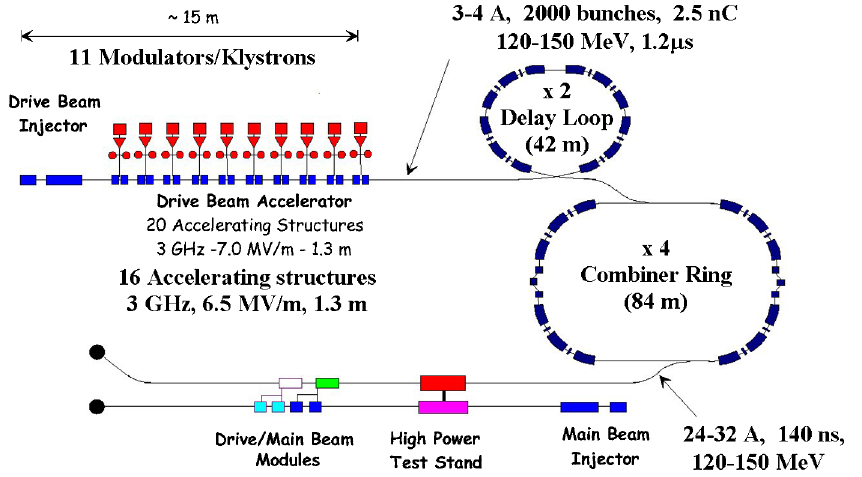
FIG. 1. Conceptual layout of